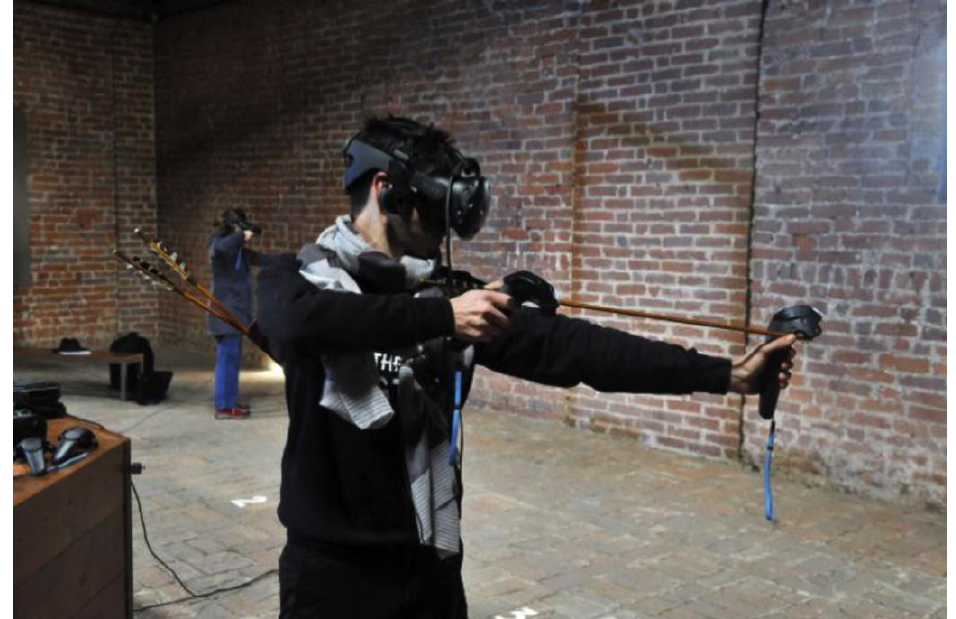
Figure 7. “Beyond The Castle” makes the user protagonist of a game through the battlements of Sforzesco Castle. A Head Mounted Display and interactive handpieces are used. Realized by Beyond the Gate, at the Castello Sforzesco in Milan, 2018.